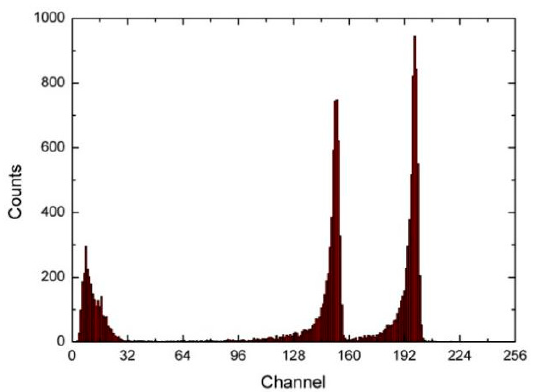
Figure 2. Typical alpha spectrum of the upgraded measurement module.